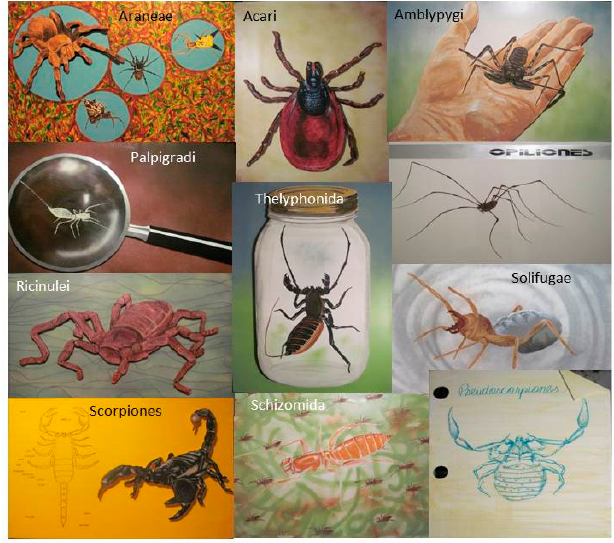
Figure 1. Original artwork painted onto foam poster boards (3 × 5 ft) and held on easels attracted participants to the eleven biodiversity stations associated with the Path of Predators .